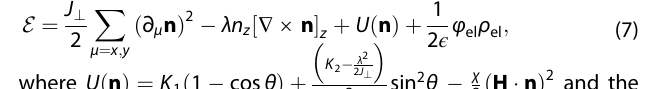
Fig. 3 Magnetic phase diagram of the model. The competing phases are: the ‘ uniform ’ (U) spiral state with n ∥ z and ψ = 0, the modulated ‘ tilted spiral ’ (TS) state and the domain wall array (DWA). Solid black(dashed red) phase transition lines are obtained analytically(numerically), the difference being a fi nite-size effect in numerical calculations. Color indicates the average n z . (cid:5) (cid:6) k 1 ; 2 ¼ K 1 ; 2 = λ 2 2 J